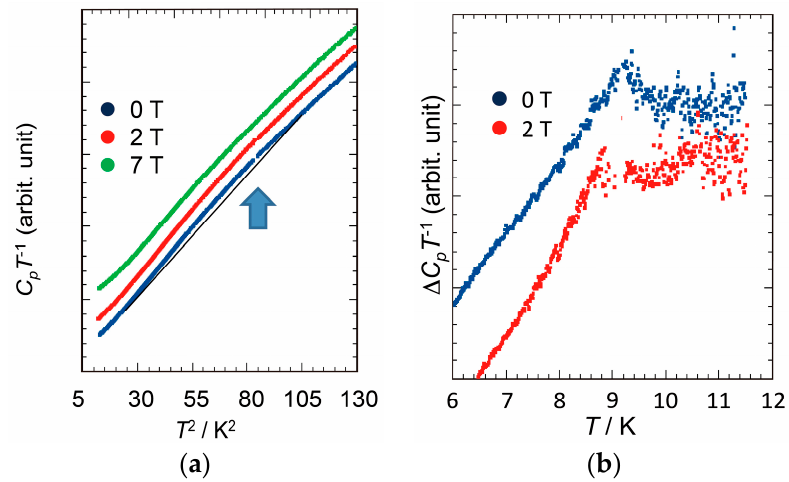
Figure 5. ( a ) C p T − 1 vs. T 2 plot of the ac heat capacity of κ -(BEDT-TTF) 2 Cu(NCS) 2 at ambient pressure with magnetic fields of 0 T, 2 T, and 7 T applied parallel to the conducting layer. The values of C p T − 1 under magnetic fields are plotted with constant offsets in the vertical axis. The arrow shows the superconductive transition temperature. ( b ) Temperature dependence of the ∆ C p T − 1 obtained by subtracting the 7-T data as the background ( ∆ C p T − 1 ( H ) = C p T − 1 ( H ) − C p T − 1 (7 T)) to evaluate the anomaly in the temperature dependence due to the electronic heat capacity around the transition (details are reported in Ref. [32]).